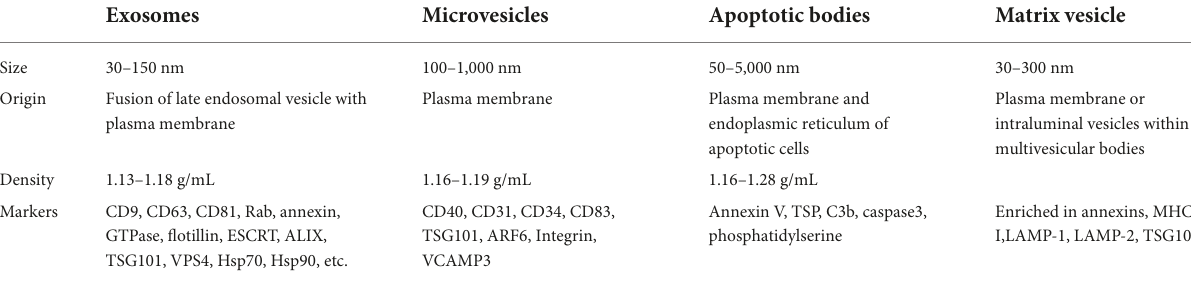
TABLE 1 Main characteristics of exosomes, microvesicles, apoptotic bodies, and matrix